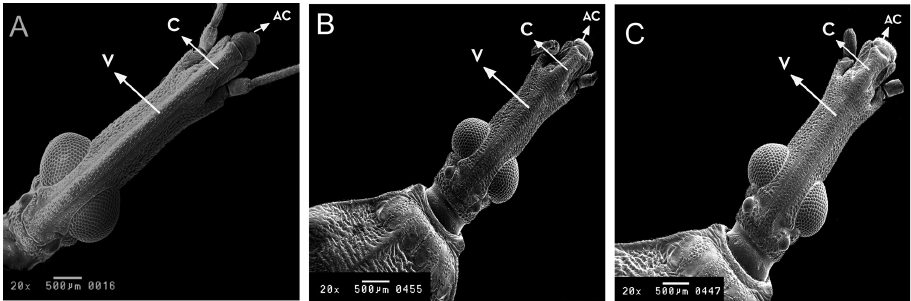
Figure 3. Head of R. marabaensis sp. n. ( A ), R. prolixus ( B ), R. robustus ( C ). V: vertice; C: clypeus; AC: anteclypeus.